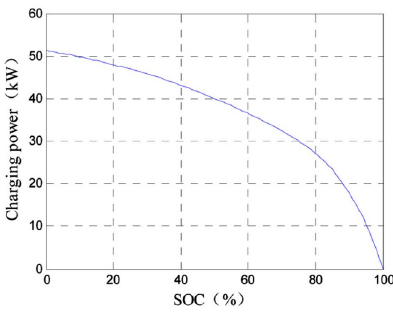
Figure 3. Charging curve of a lithium-ion battery equipped in a Nissan Altra EV. SOC: state of charge.